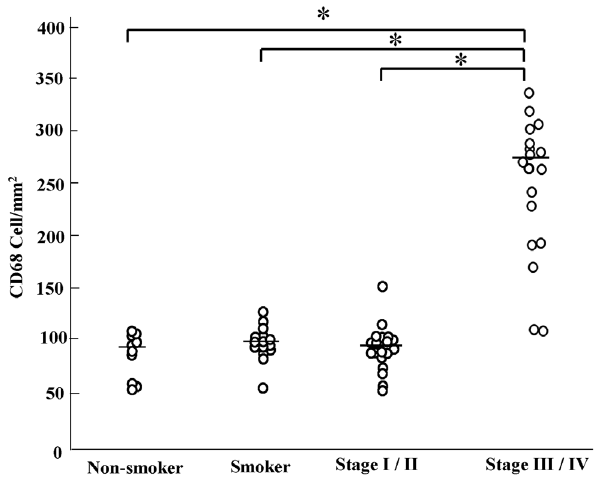
Figure 2. The number of CD68 positive cells in non-smoker, smoker and chronic obstructive pulmonary disease patient (COPD). *: p , 0.01. The Global Initiative for Chronic Obstructive Lung Disease (GOLD) clinical criteria for the diagnosis and severity of COPD stage I: mild, II: moderate, III: severe, IV: very severe.